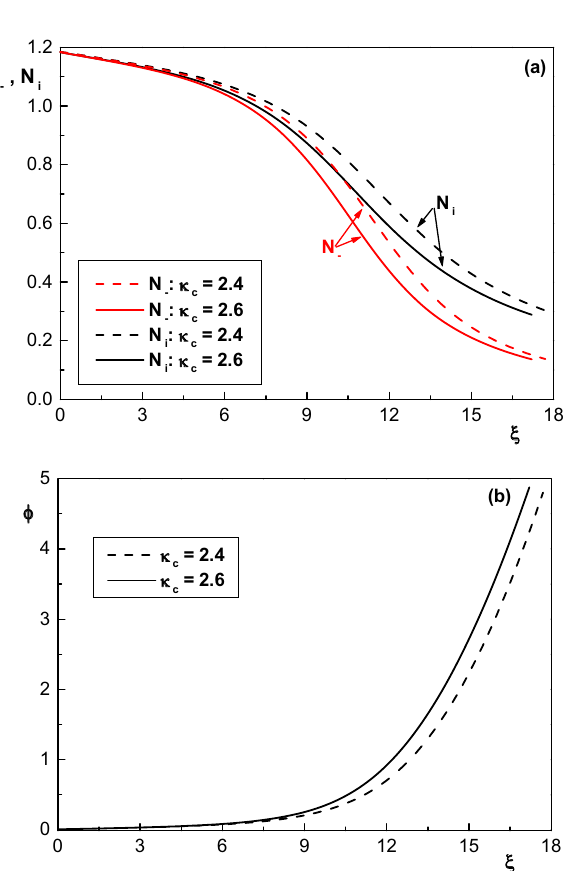
Figure 5. Spatial distribution of ( a ) normalized density of positive and negative particles and ( b ) normalized sheath potential for φ 0 = 0.008 , σ h = 10 , σ i = 0.02 , m = 1 / 1836 , κ h = 4 , δ = 0.2 , δ b = 0.002 and different values of κ c